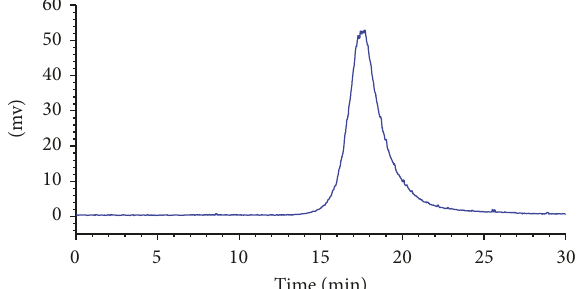
Figure 4: HPGPC chromatogram of RGP2-1 on TSK-GEL G4000PWXL